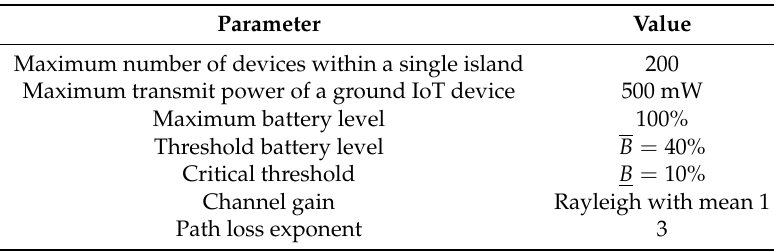
Table 1. Simulation